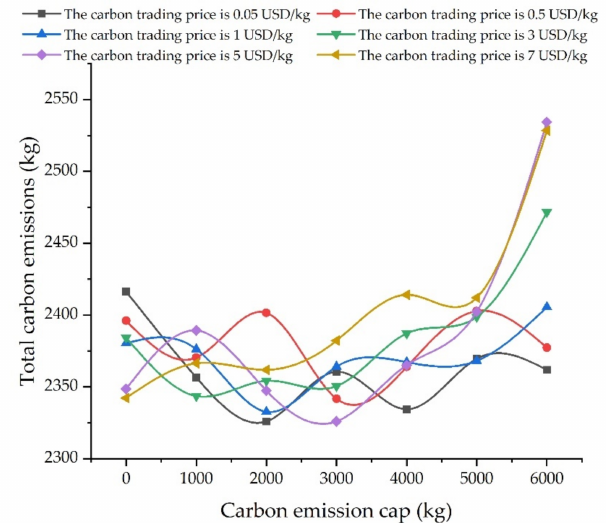
Figure 16. The relationship between total carbon emission and carbon trading price and carbon emission